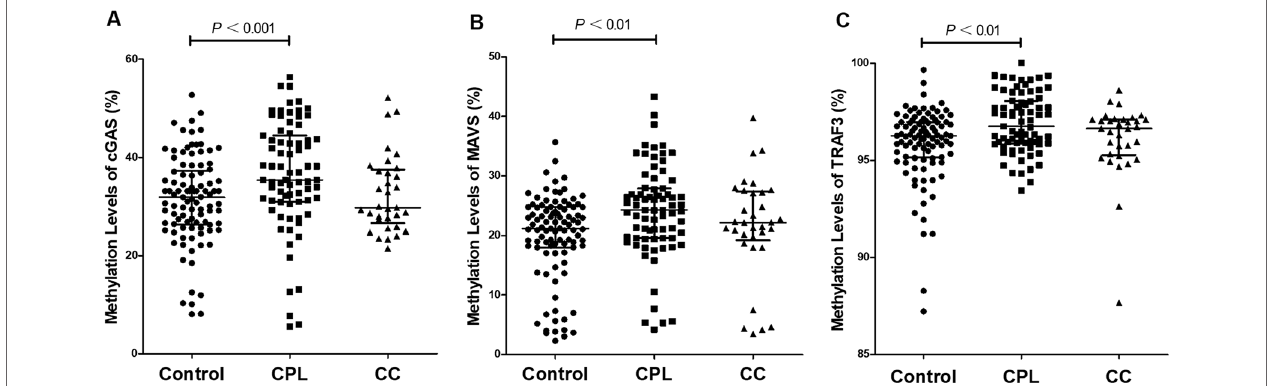
FiGURe 2 | Comparison of gene promoter methylation levels. (A) Cyclic GMP-AMP synthase ( cGAS) , (B) mitochondrial antiviral-signaling ( MAVS) , (C) tumor necrosis factor receptor-associated factor 3 ( TRAF3) . The reference is control group, and differences between pairs were assessed using Mann-Whitney U test. Scatter dot plot represents the methylation level and the line in plot present the median with interquartile range.